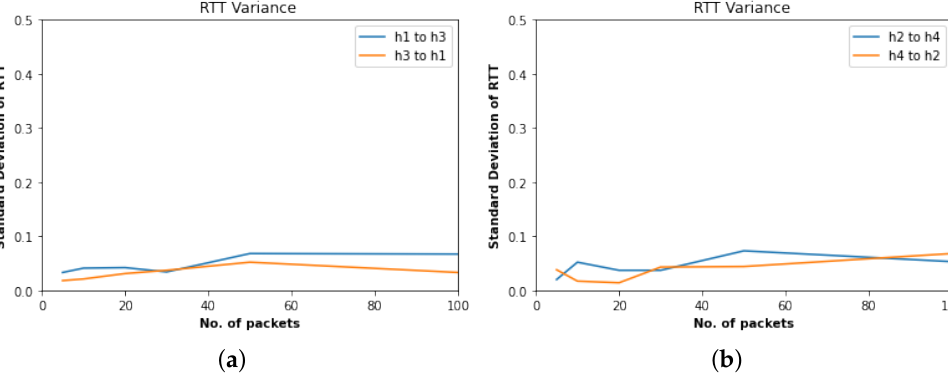
Figure 13. RTT Variance for Neighbouring AS of Legacy Network, ( a ) h1 <-> h3 and ( b ) h2 <-> h4.